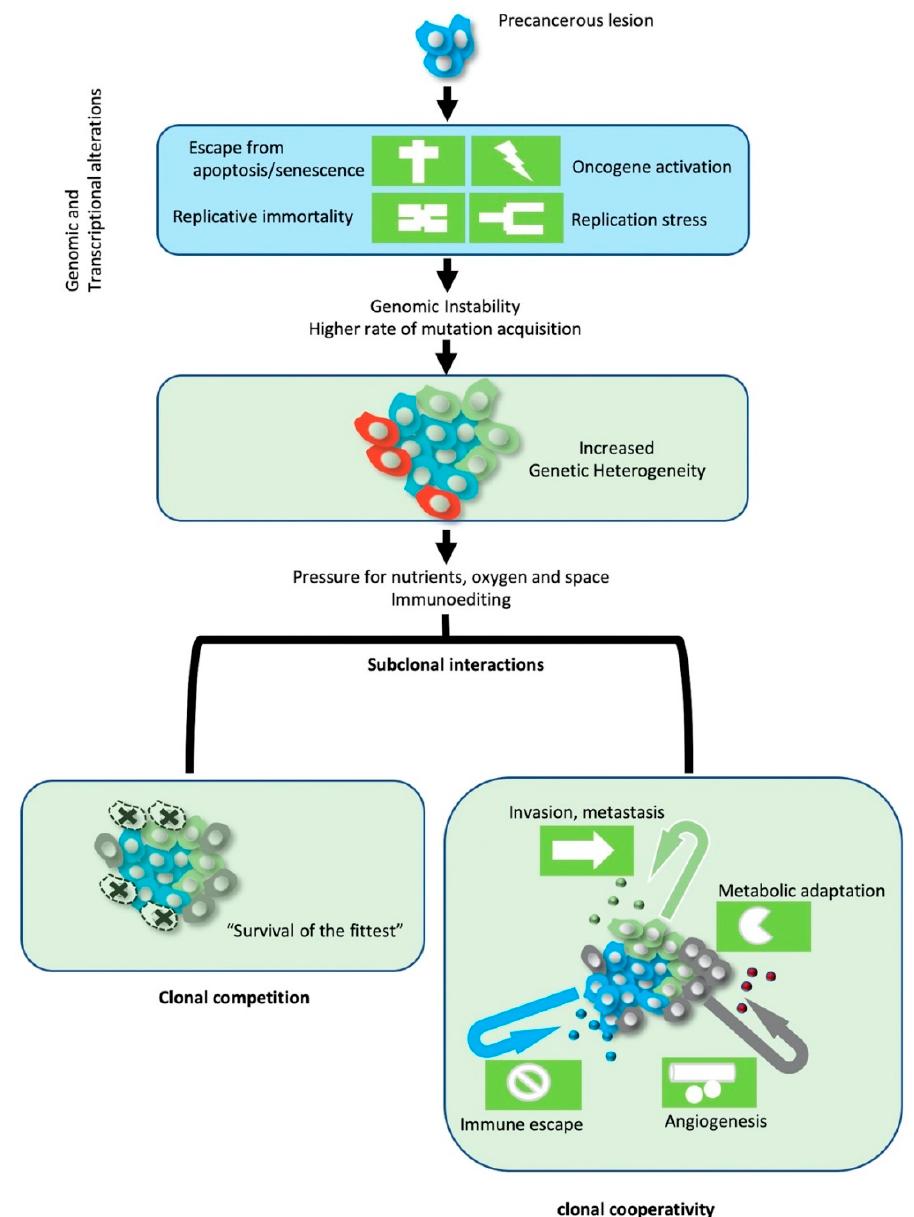
Figure 2. Tumor heterogeneity and clonal interactions. Oncogene-induced replication stress drives genomic instability and clonal heterogeneity within tumors. Selective pressures and complex subclonal interactions within the tumor ecosystem drive the evolutionary and ecological features of growing tumor.